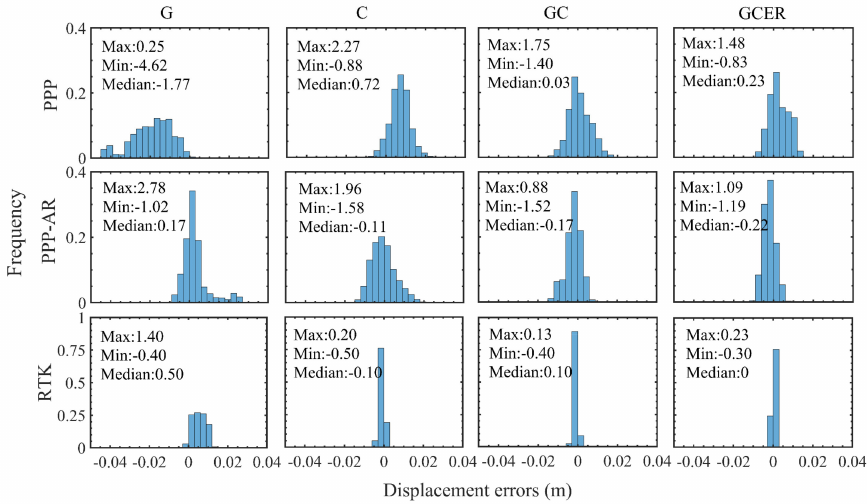
Figure 6. Histograms of displacement errors. From top to bottom, results from PPP, PPP-AR, and RTK; from left to right, results calculated by G, C, GC, and GCER, respectively. Statistics (maximum, minimum, and median) of each time series are given in each plot (in